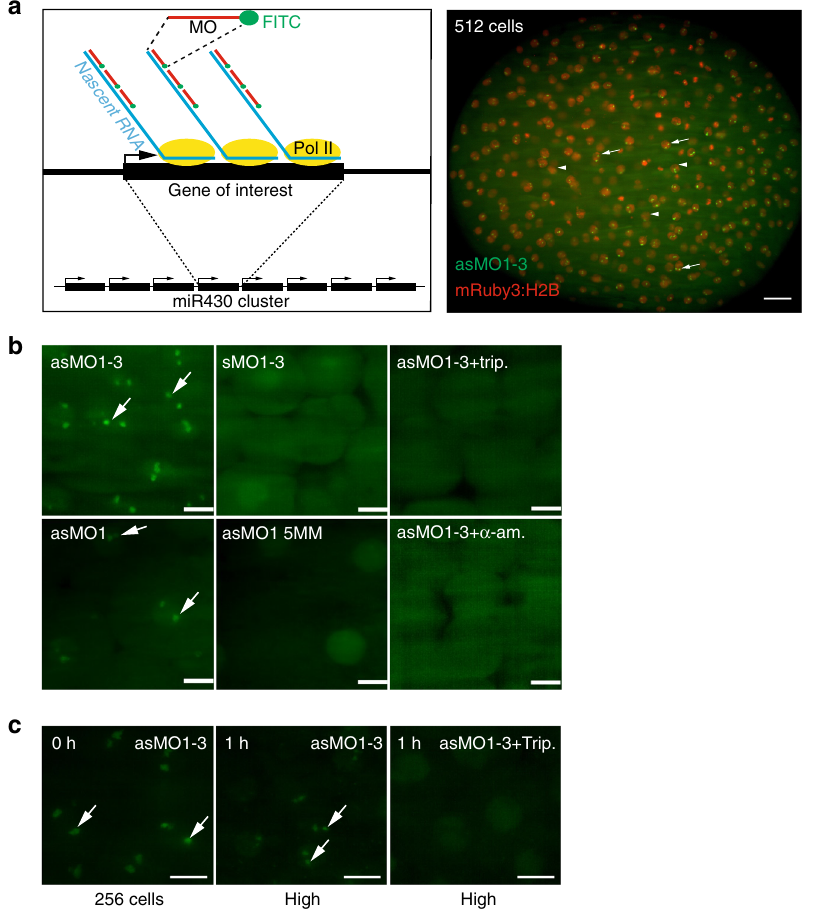
Fig. 1 MOVIE detects native transcripts at the site of transcription in living zebra fi sh embryos. a Left: schematic of the detection principle of transcript imaging by MOVIE at the miR430 primary miRNA gene cluster. Right: Image of whole embryo, imaged in vivo by lightsheet microscopy, injected with three antisense, FITC-labelled morpholinos (MO) targeting miR430 priRNA (green) and mRuby3:H2B fusion protein as nuclear marker (red). Arrows point at signal accumulation, appearing as double green punctae within the nuclei, labelled by mRuby3:H2B (arrowheads). b Representative images of live embryos, imaged in vivo at high/oblong by lightsheet microscopy, injected at zygote stage with triple and single sense, antisense and mismatch-containing, FITC- labelled morpholinos and transcription blockers ( α -amanitin or triptolide, n = 6 embryos each). c Transcript signal detection before and after 1-hour triptolide treatment started at 256-cell stage (0 h), (n = 6 embryos each). Stages of embryos as indicated in panels. trip triptolide, as antisense, s sense, MO morpholino oligonucleotide (where number depicts speci fi c MO, for details see Supplementary Table 1), 5 MM 5 mismatch containing, h hours after treatment. Scale bars: a 50 µ m b , c 10 µ